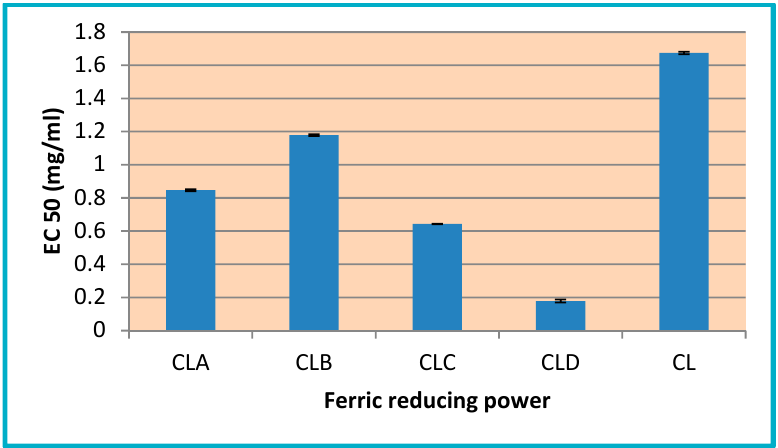
Figure 4. Ferric reducing power (EC50 mg/mL) of chitosan nanoparticles and its derivatives (CL, CLA-CLD).